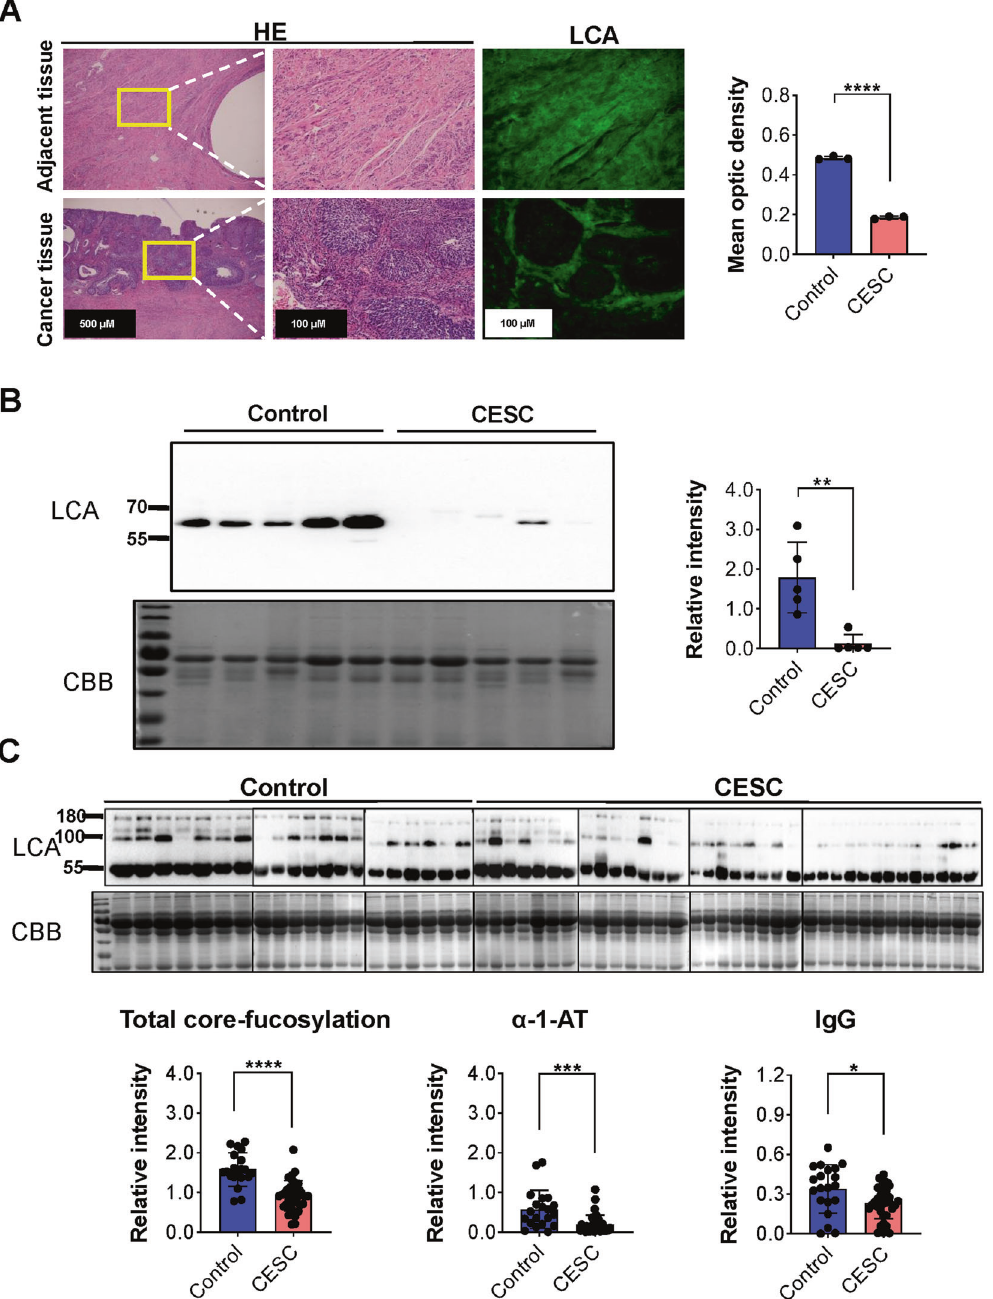
Fig. 1 Comparison of core fucosylation between healthy volunteers and cervical cancer patients. A Immuno fl uorescence was used to analyze the core fucosylation level of cervical cancer and paracancerous tissues. B LCA blotting was used to compare the core fucosylation levels in exfoliated cervical cells. C LCA blotting was used to compare the core fucosylation levels in serum samples. * p < 0.05, ** p < 0.01, *** p < 0.001, **** p <